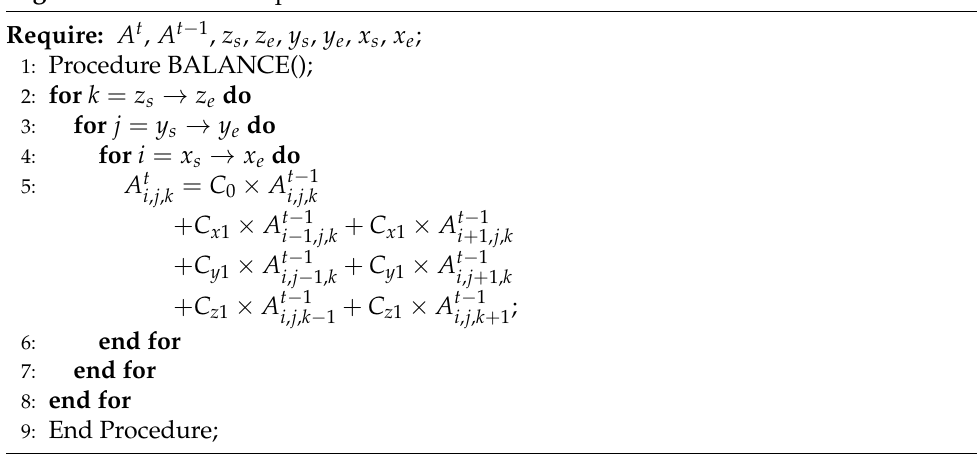
Algorithm 9 Stencil computation with load